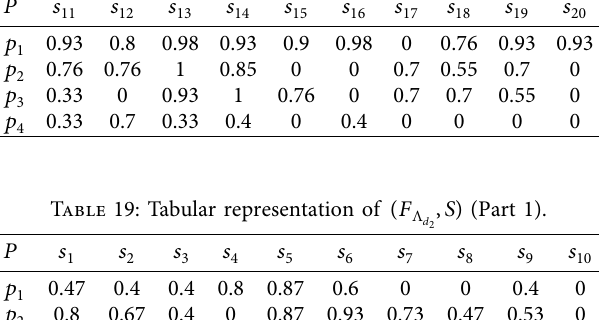
Table 18: Tabular representation of ( F